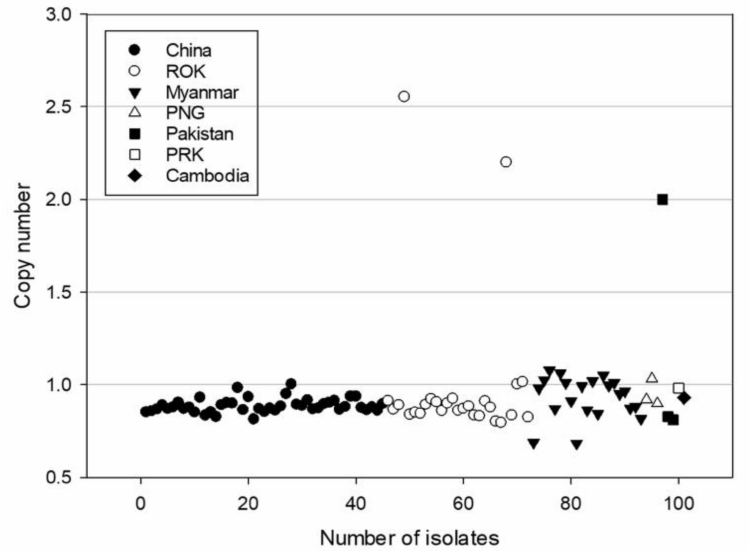
Figure 2. A scatter-gram depicting pvmrp1 copy number estimates for P. vivax isolates from seven countries. ROK, the Republic of Korea; PNG, Papua New Guinea; PRK, the Democratic People’s Republic of Korea. Table 3. Comparison of pvmrp1 substitutions between CQ sensitive and CQ resistant isolates.